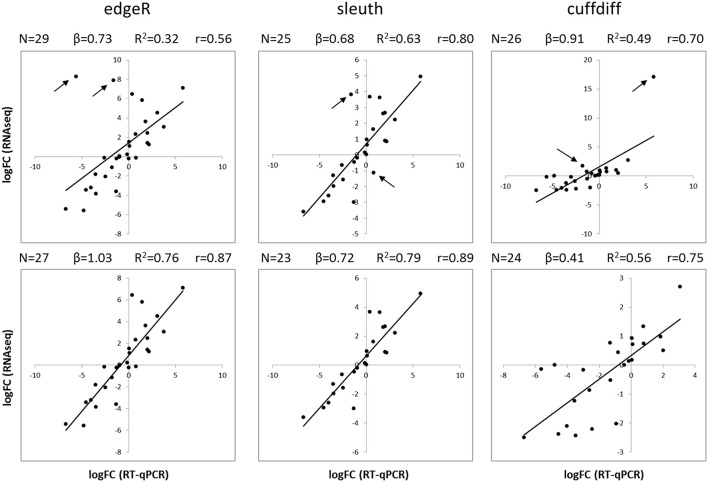
Comparison of RT-qPCR and RNAseq gene expression results. Scatterplots show the logFC of isoforms obtained with RT-qPCR (horizontal axis) and with RNAseq (vertical axis). LogFC values from RNAseq were obtained with three different analysis methods: edgeR (left), sleuth (center) and Cuffdiff (right). Plots on the top show all available data, whereas plots on the bottom show data after removing the two most scattered data points (black arrows). Black lines correspond to a linear regression. N, number of data points; β, slope of regression; R2, coefficient of determination; r, Pearson correlation coefficient.